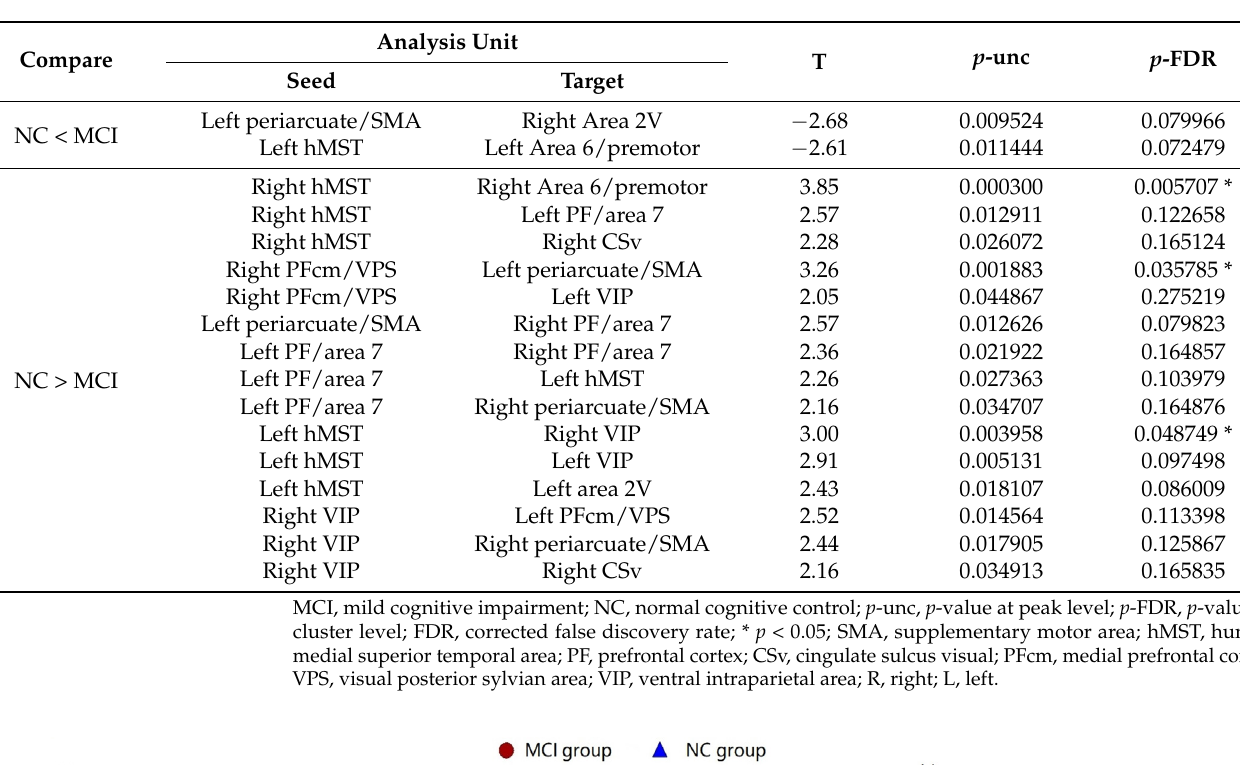
Table 2. Resting state pairwise connections in the MCI group compared to those of the NC group.